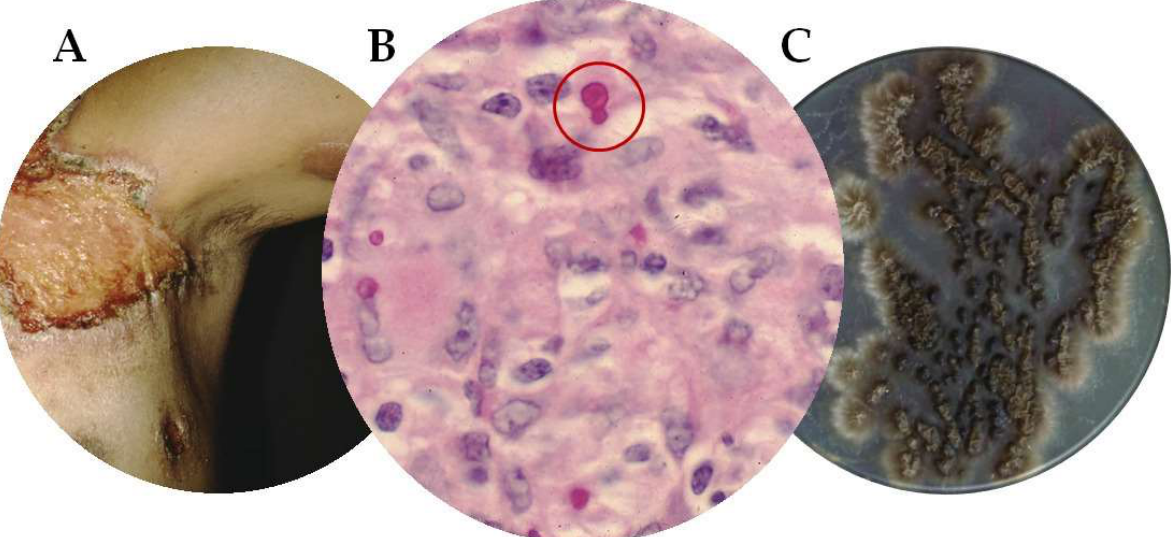
Figure 1. Common characteristics of Sporotrichosis. ( A ) Sporothrix chancre, ( B ) Sporothrix yeasts on PAS-stained smears, ( C ) culture of Sporothrix spp. on Sabouraud dextrose agar with folded appearance.